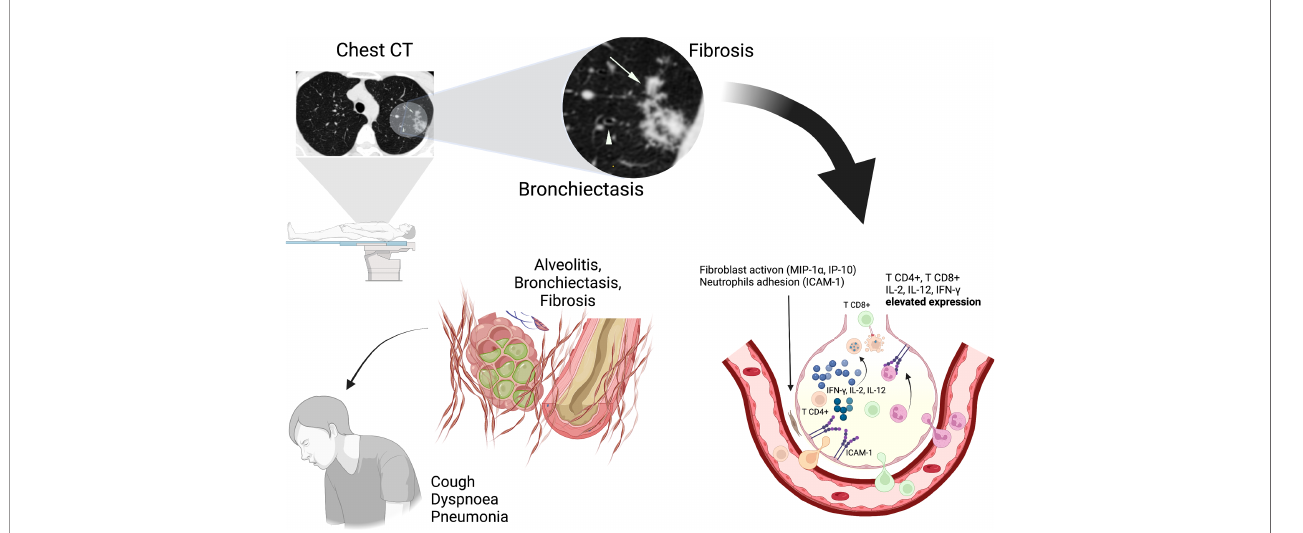
FIGURE 2 | Pulmonary in fl ammation involves the interaction between cytokines (IL-2, IL-12, and IFN- g ) and chemokines (MIP-1 a and IP-10) with HTLV-1 infected CD4+ T cells resulting in lung injuries (alveolitis, bronchiectasis). ICAM-1 facilitates the adhesion of neutrophils and potentiates the chronic in fl ammation. Chest CT imaging shows Bronchiectasis (Arrowhead) that indicates enlargement and deformation of airway and Centrilobular nodule (Arrows) that indicates Fibrosis, bronchiolitis and alveolitis at sites of injury. These alterations determine a chronic evolution with presence of symptoms (Cough, Dyspnoea,